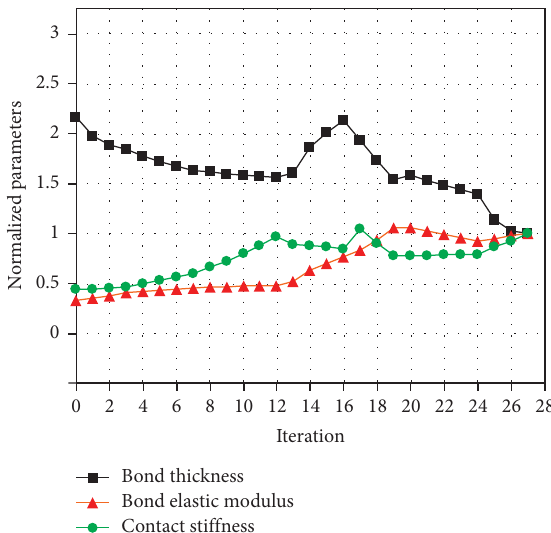
Figure 11: Changes in the three model-updating parameters of the FE